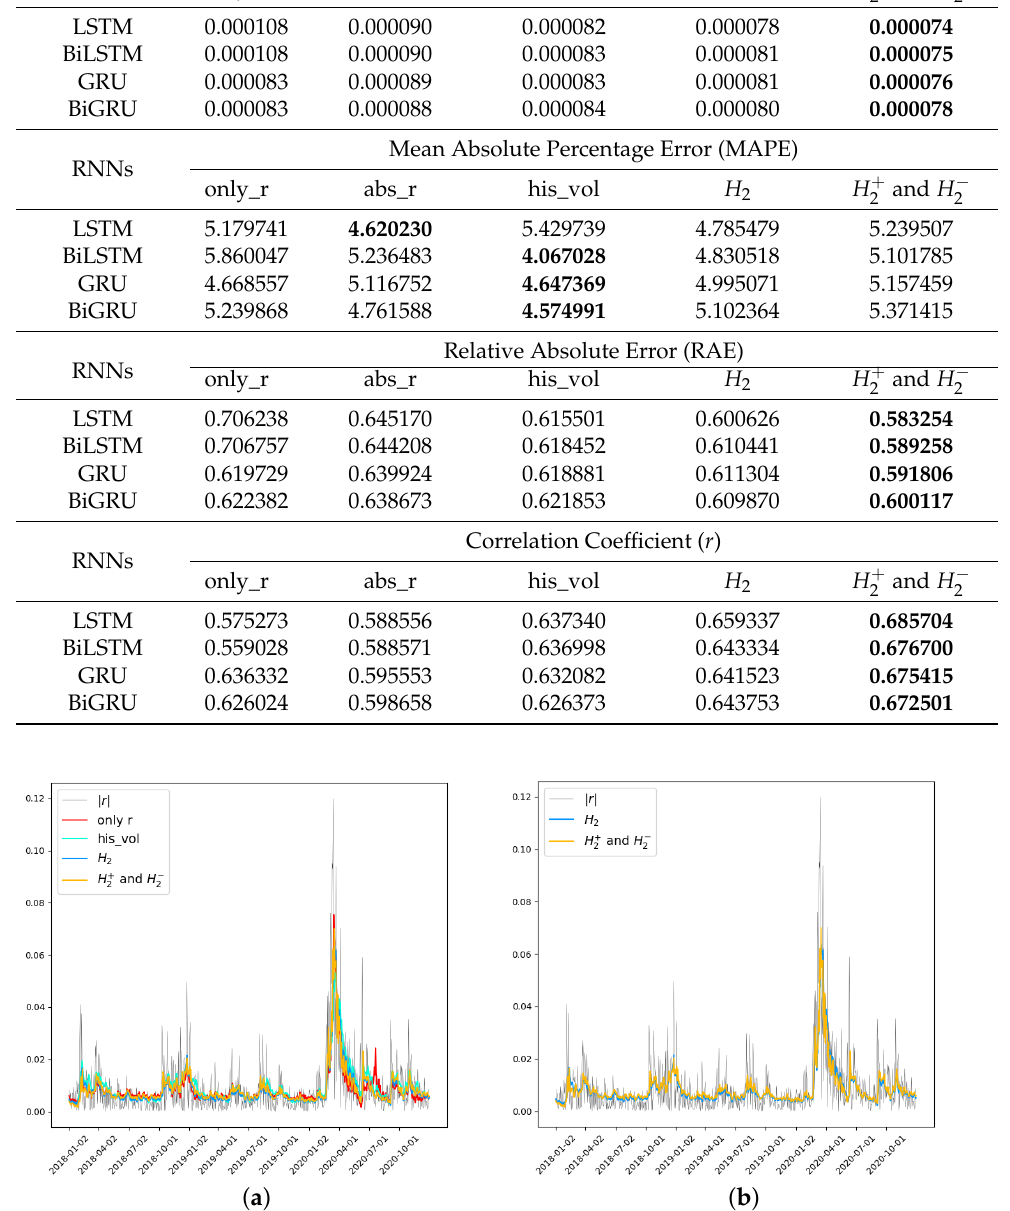
Figure 3. Forecast performance of absolute return. ( a ) All models. ( b ) Multifractal